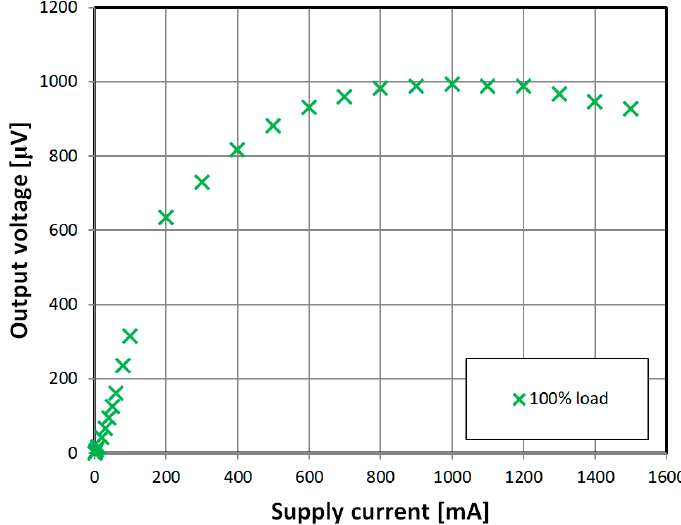
Figure 15. Obtained experimental characteristic of unamplified output voltage at 100% load (12 N) for ‘diagonal’ sensor for different magnetizing coil currents.